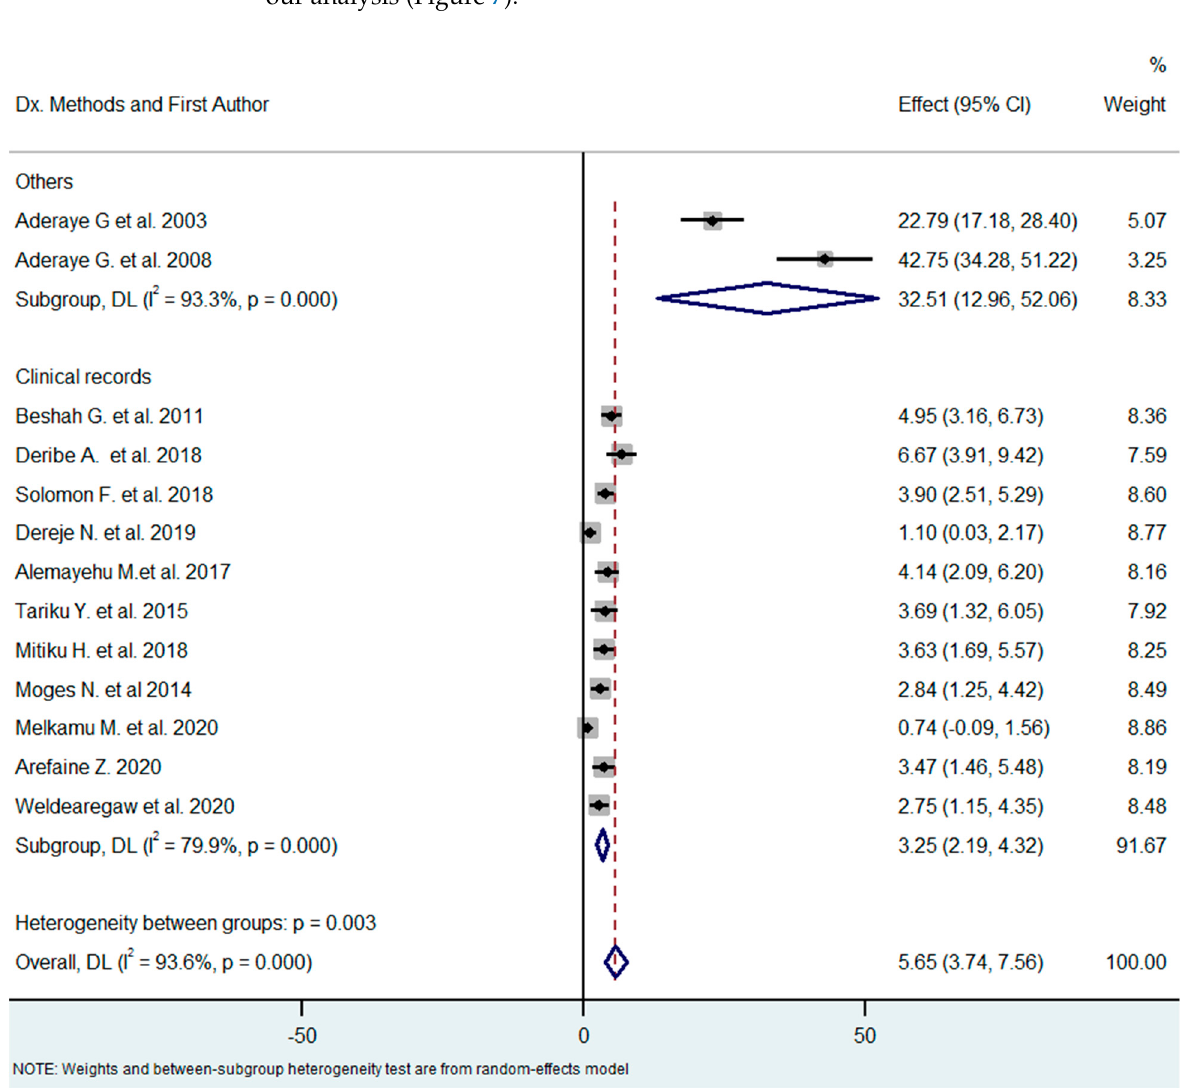
Figure 6. Subgroup analysis by methods of diagnosis [18,21,26–36].